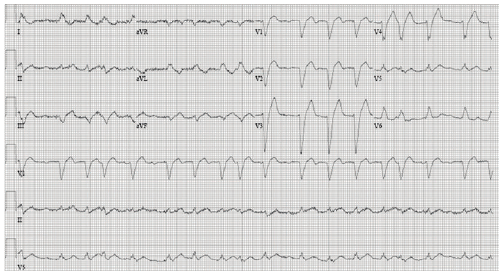
Figure 1: ECG on presentation demonstrating new onset atrial fibrillation and LBBB.